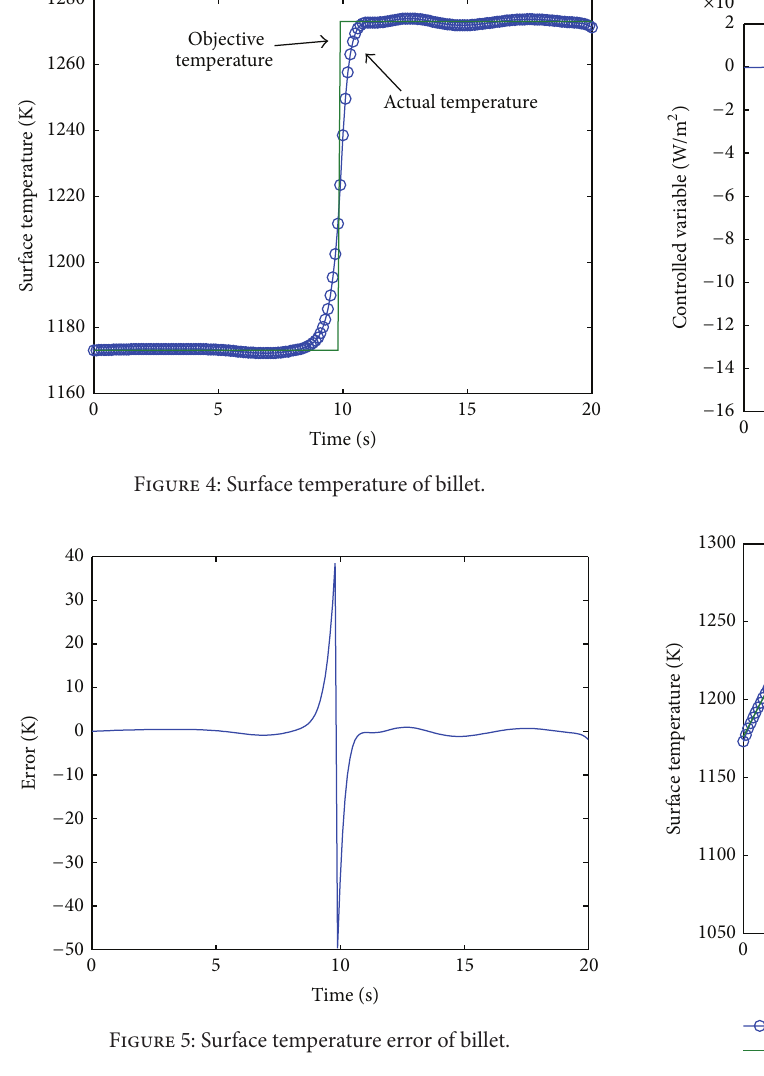
Figure 7: Surface temperature of